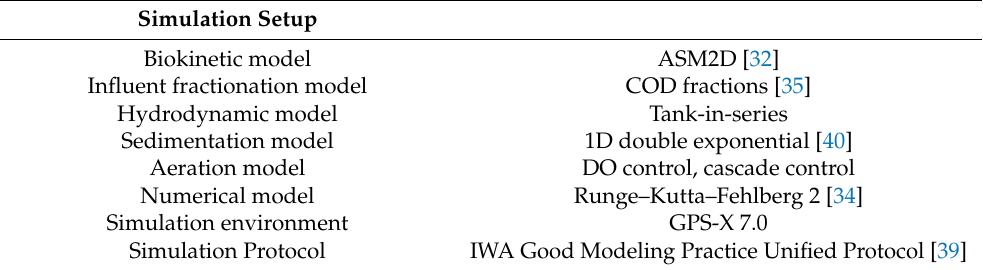
Table 1. The applied plant-wide modeling